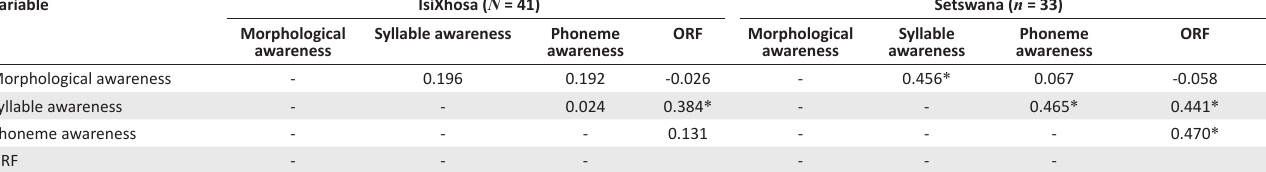
TABLE 6: R -values of Pearson correlations between morphological awareness, syllable awareness, phoneme awareness and oral reading fluency. Variable